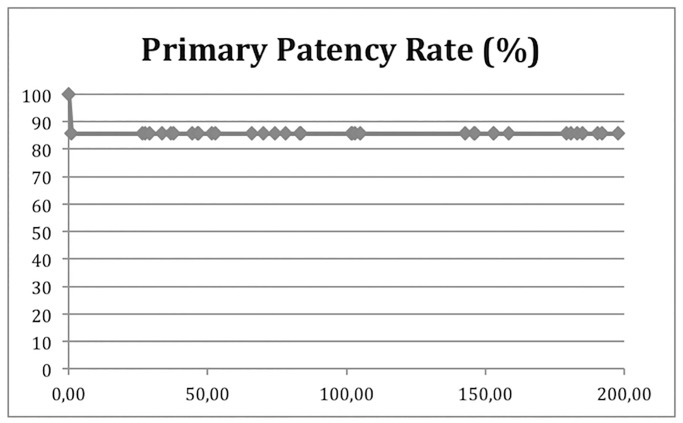
Patency rates.Kaplan-Meier estimation for primary patency rate in patients with iliofemoral DVT after surgical venous thrombectomy (horizontal axis: month after surgery, vertical axis percentage of open iliofemoral segments).